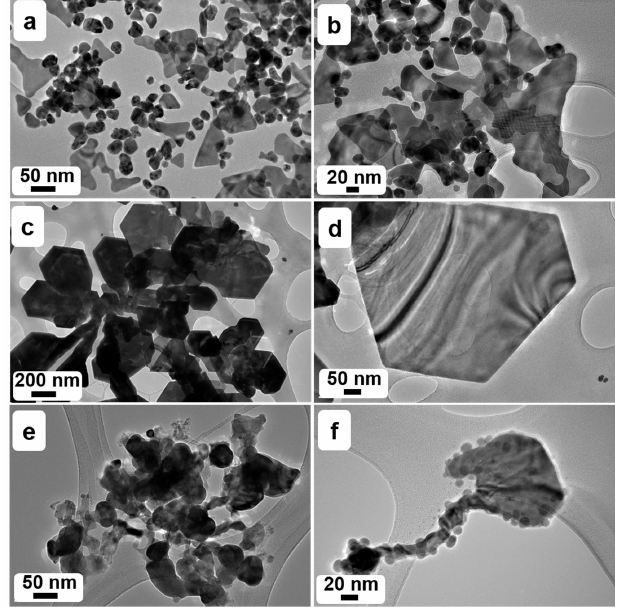
Figure 4. TEM images showing the morphologies of Au ( a , b ), Ag ( c , d ), and phase-separated Au–Ag ( e , f ) NPs using low concentrations of PE.